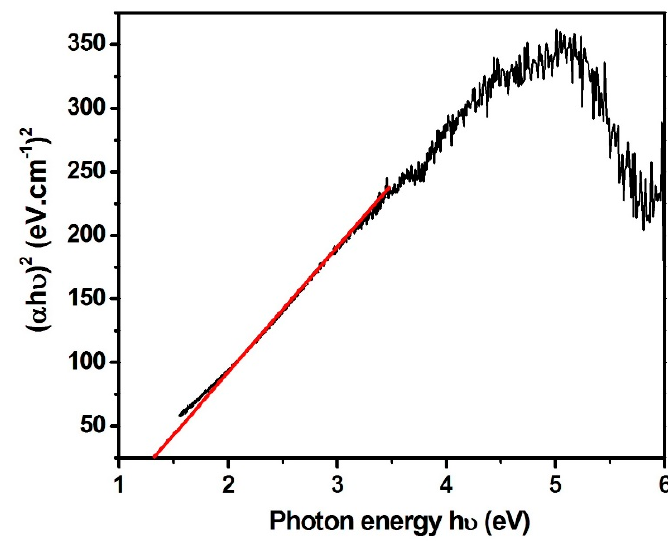
Figure 12. Plot between ( α h ν ) 2 and h ν for pure MoS 2 .